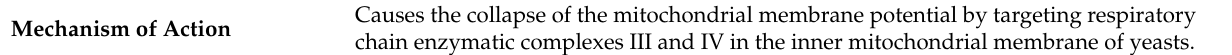
Table 1. Key features of T-2307.